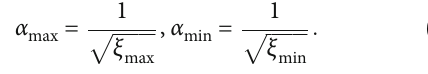
Figure 7: Variation of the total pressure loss coe ffi cients, ξ pressure jumps, respectively, as a function of the nominal gust frequency, f N reservoir volume V is (a) 0.022m 3 , (b) 0.011m 3 , (c) 0.0062 m 3 , (d) 0.0033m 3 , and (e) 0.0016m 3 R